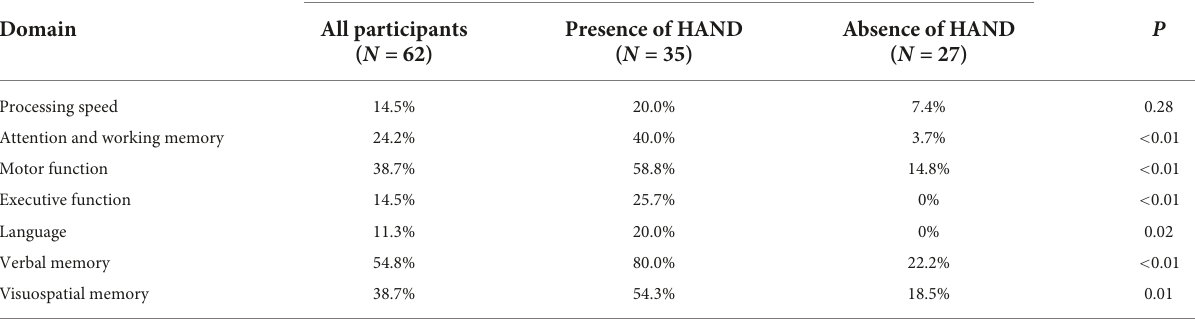
TABLE 4 Prevalence of within-domain impairment among the study